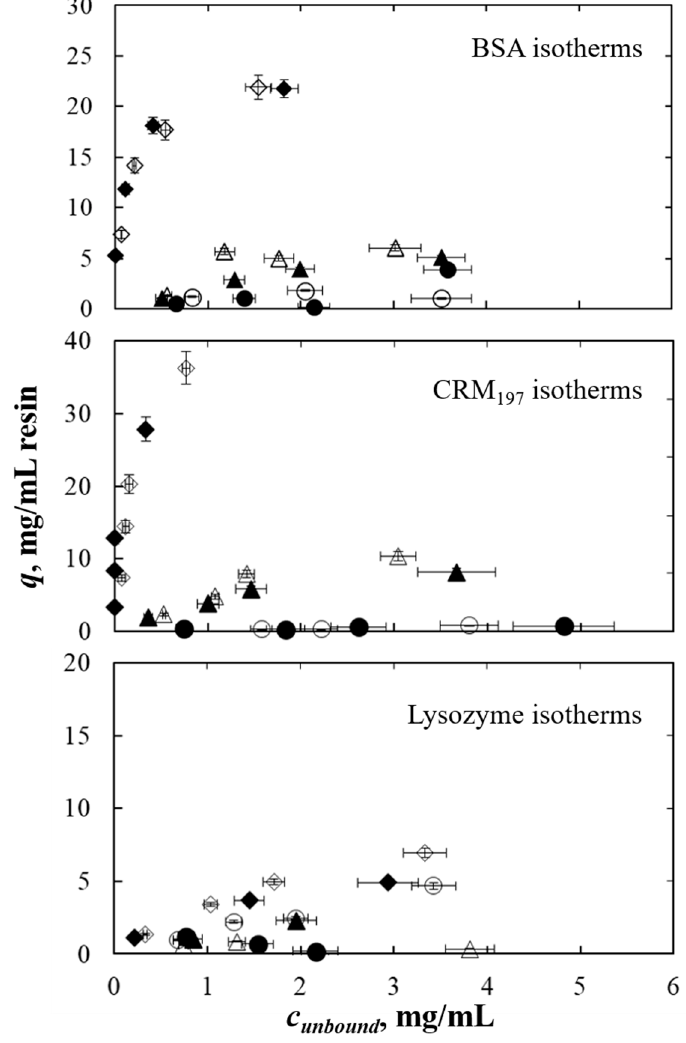
Figure 1. Comparison of adsorption isotherms obtained with UV-Vis spectrophotometer and LabChip for the BSA, CRM 197 and lysozyme when investigated as a single-component at different salt concentrations. For each protein, full symbols refer to LabChip analysis, while empty symbols refer to UV-Vis spectrophotometer analysis. Circles, triangles and diamonds refer to isotherms obtained at 0, 0.5 and 1 mol/L of ammonium sulfate, respectively.